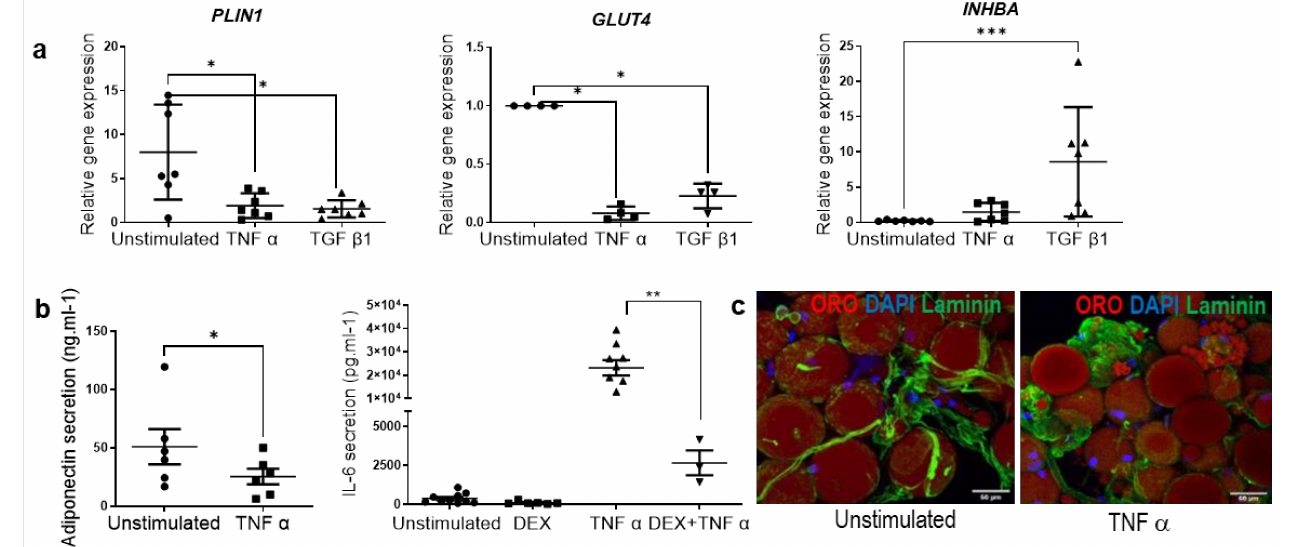
Figure 4. Generation of the ExAdEx inflamed-like model. ( a ) Regulation of PLIN1 , GLUT4 and INHBA gene expression in ExAdEx–TNF α and ExAdEx–TGF β 1 models. ( b ) Levels of adiponectin secretions. One hundred mg of ExAdEx was maintained in vitro for 30 days and then treated or not with 10 ng/mL TNF α for 7 days. Levels of secretion during the last 24 h of the treatment were determined by ELISA; n = 6 donors. Levels of IL6 secretions. One hundred mg of ExAdEx was maintained in vitro for 30 days and then treated or not with 0.25 µ M dexamethasone or 10 ng/mL TNF α or both for 7 days. Levels of secretion during the last 24 h of the treatment were determined by ELISA; n = 9 donors. * p ≤ 0.05; ** p ≤ 0.01; *** p ≤ 0.001 using the Mann–Whitney test. ( c ) The remodeling of the extracellular matrix in the inflamed ExAdEx model. The ExAdEx and ExAdEx-TNF α models were fixed and stained with anti-laminin antibodies and with ORO for lipid